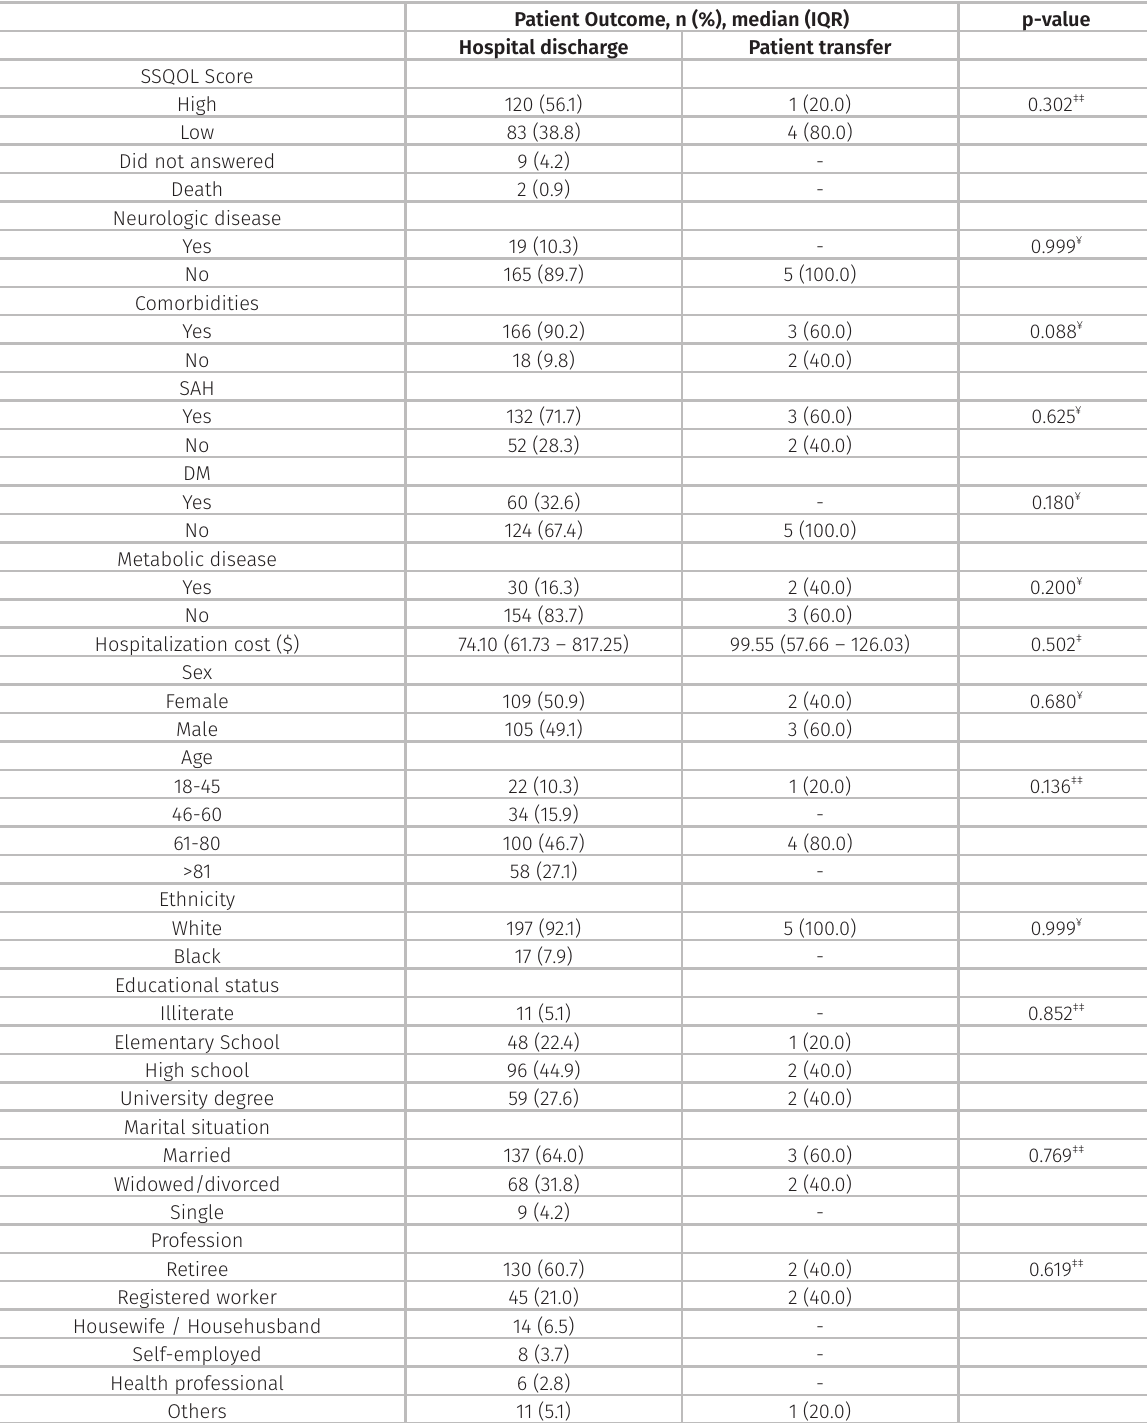
Table IV. Correlations of patient outcome, clinical history and sociodemographic characteristics with HRQOL in adult population admitted by stroke diagnosis in a private hospital in southern